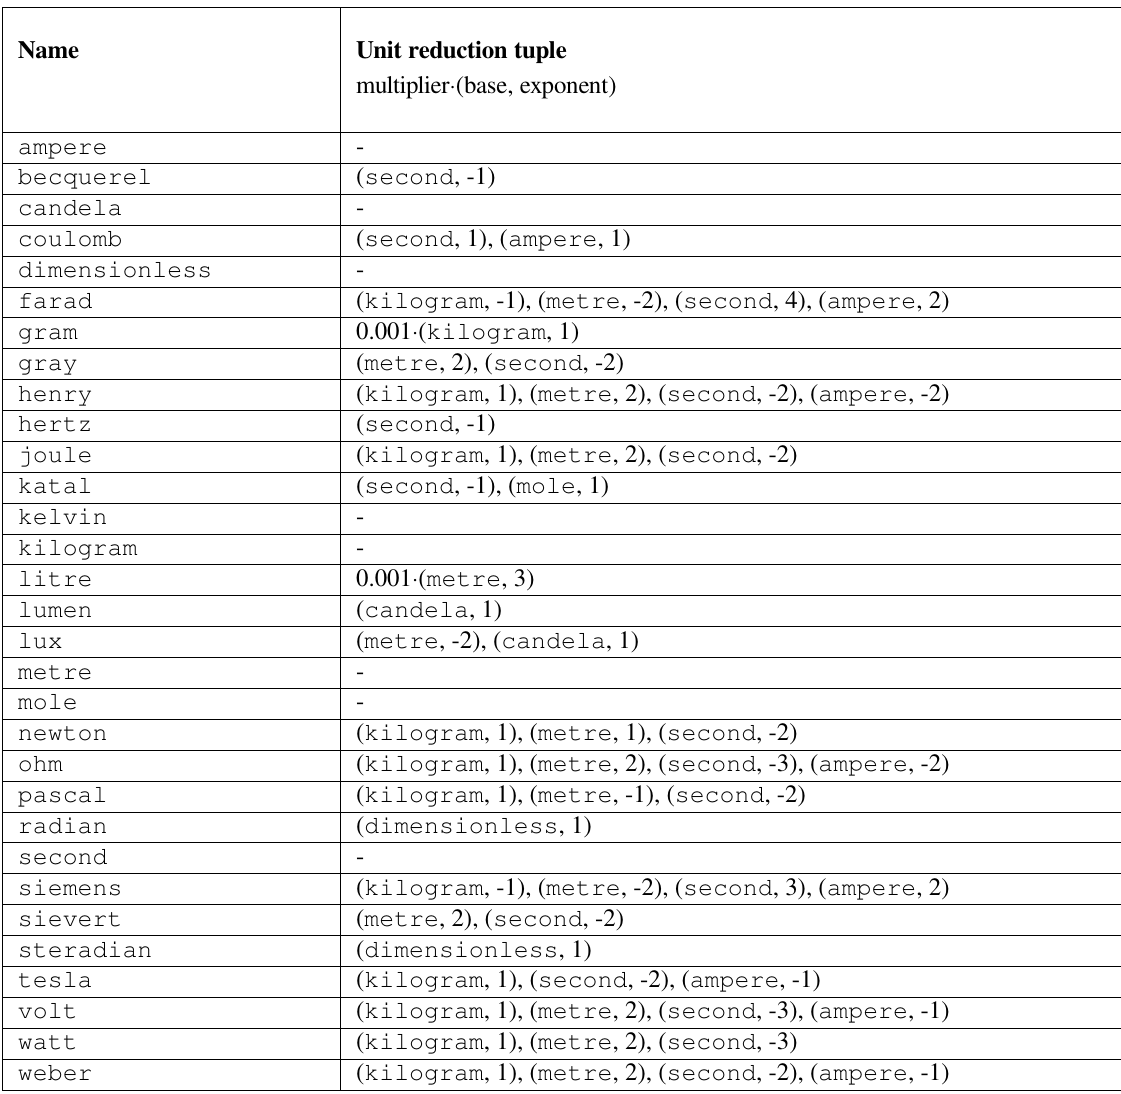
Table 3.1: Built-in